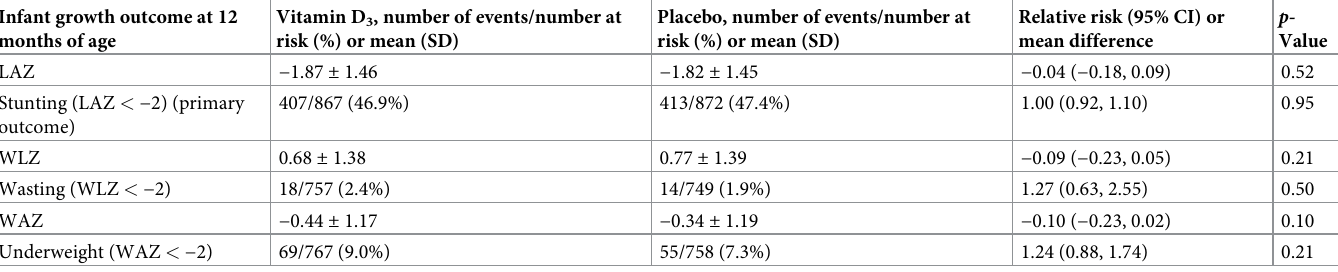
Placebo, number of events/number at risk (%) or mean (SD)